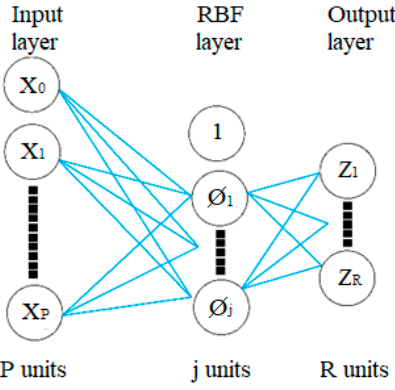
Figure 4. The Radial Basis Function (RBF) neural network diagram.